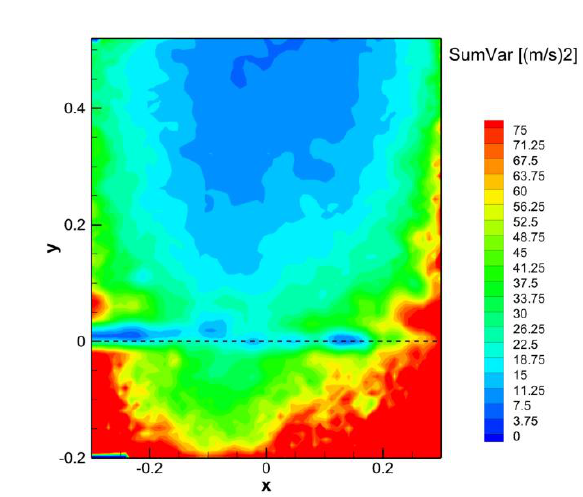
Fig. 22. RMS vorticity distribution. Re =